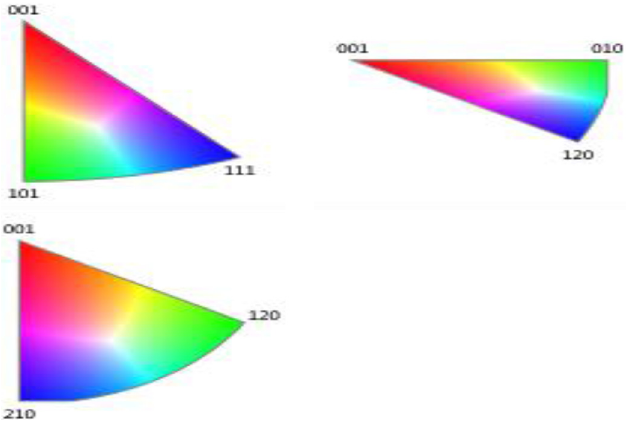
Fig. 5. Inverse pole maps of the consolidated